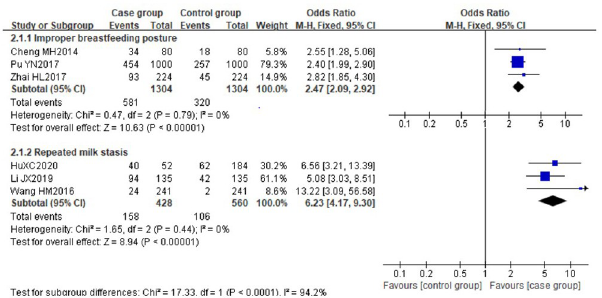
Fig 2. Forest plot comparing the pooled risks of improper breastfeeding posture and repeated milk stasis.